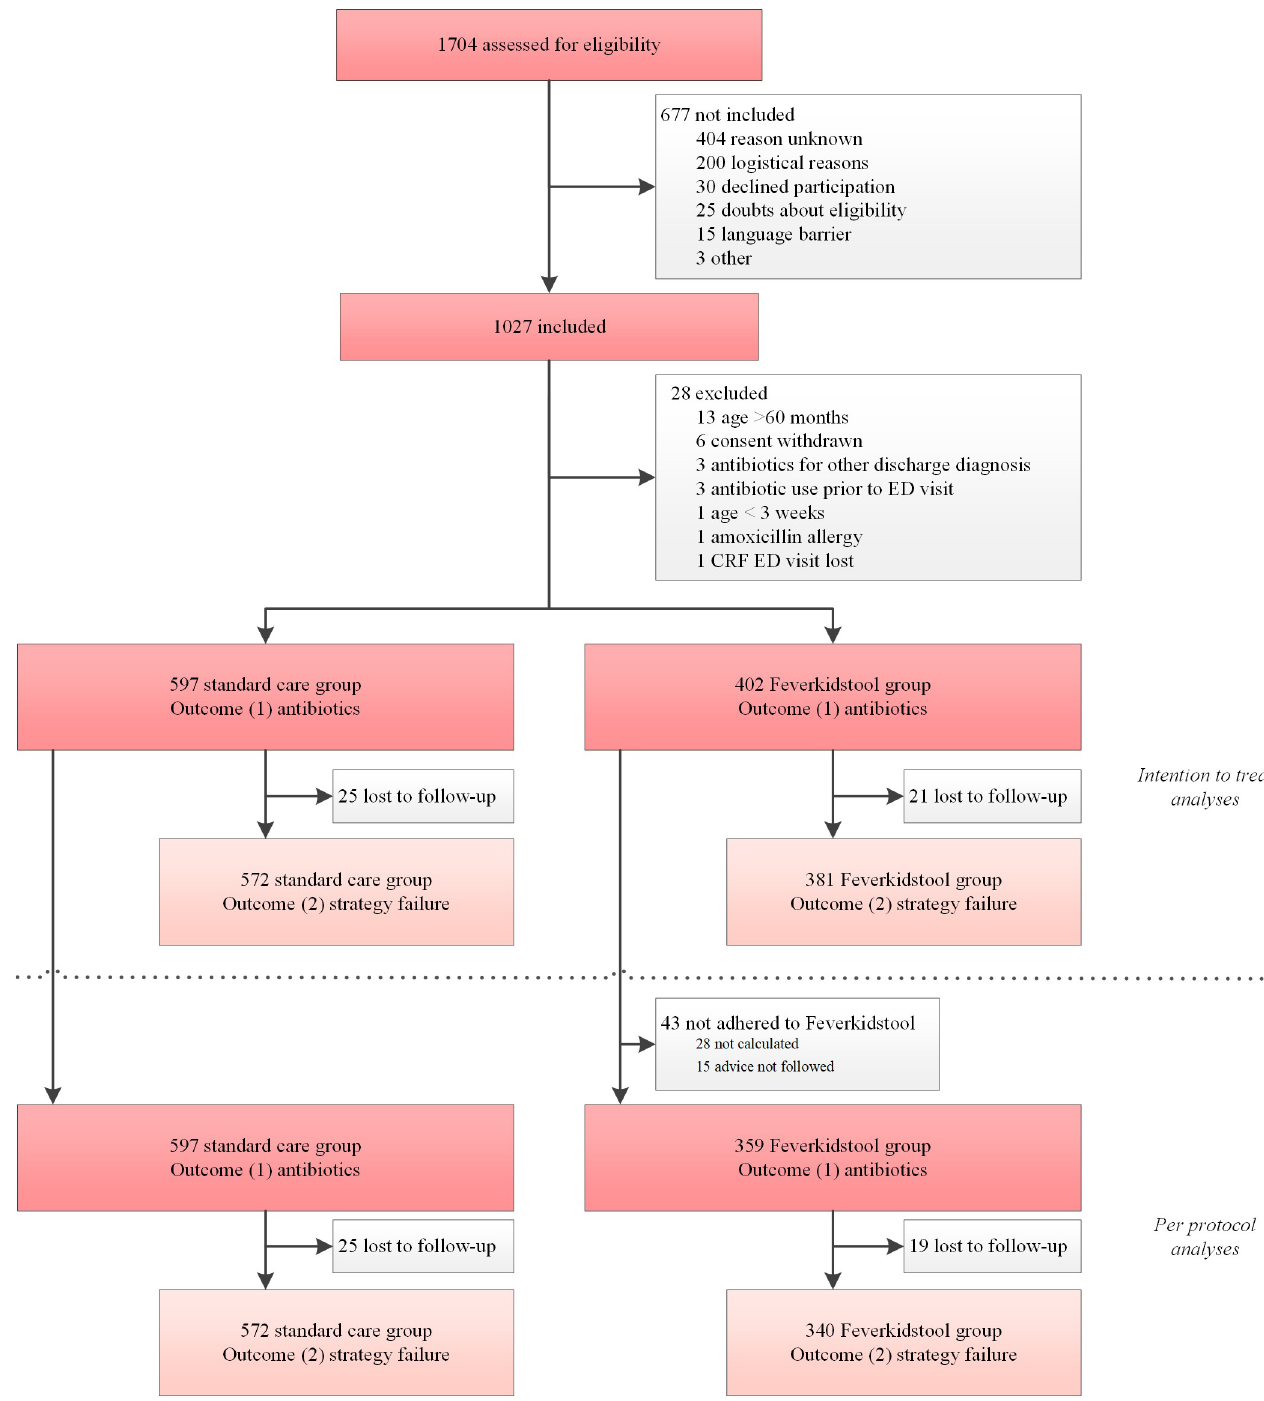
Fig 2. Flowchart of inclusion. CRF, case report form; ED, emergency